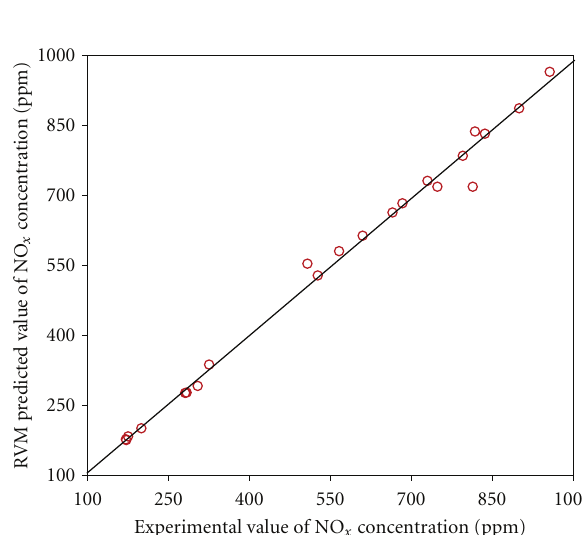
Figure 6: Comparison between RVM predicted values and the cor- responding actual values for PM mass concentration.